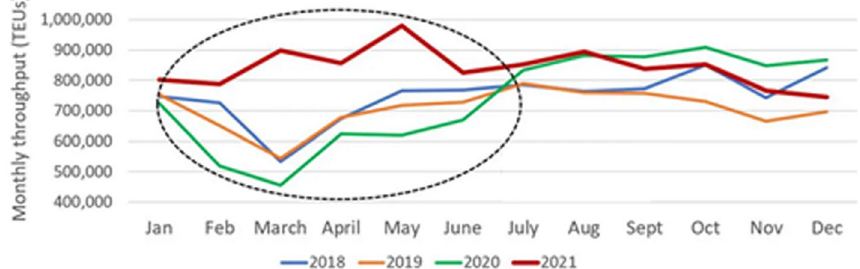
Fig. 5 Combined monthly container imports by year (Los Angeles and Long Beach) Source: American Shipper